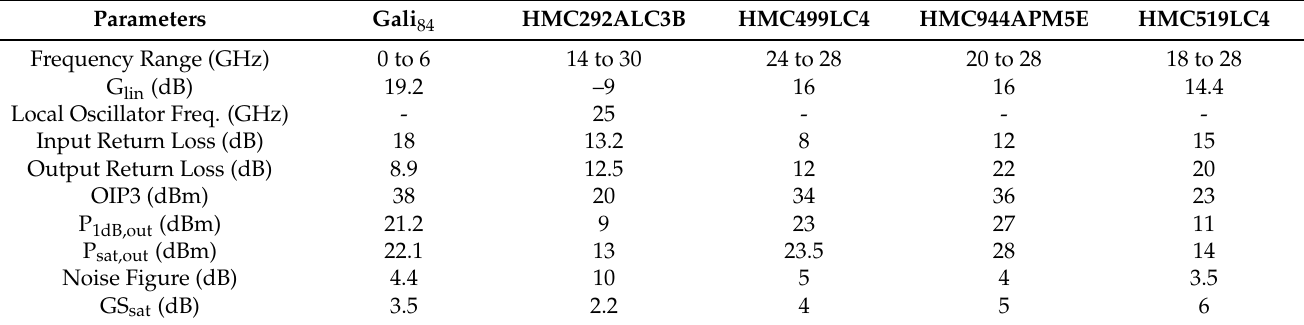
Table 2. Parameters of the elements of mmWave transmitter and receiver chains.